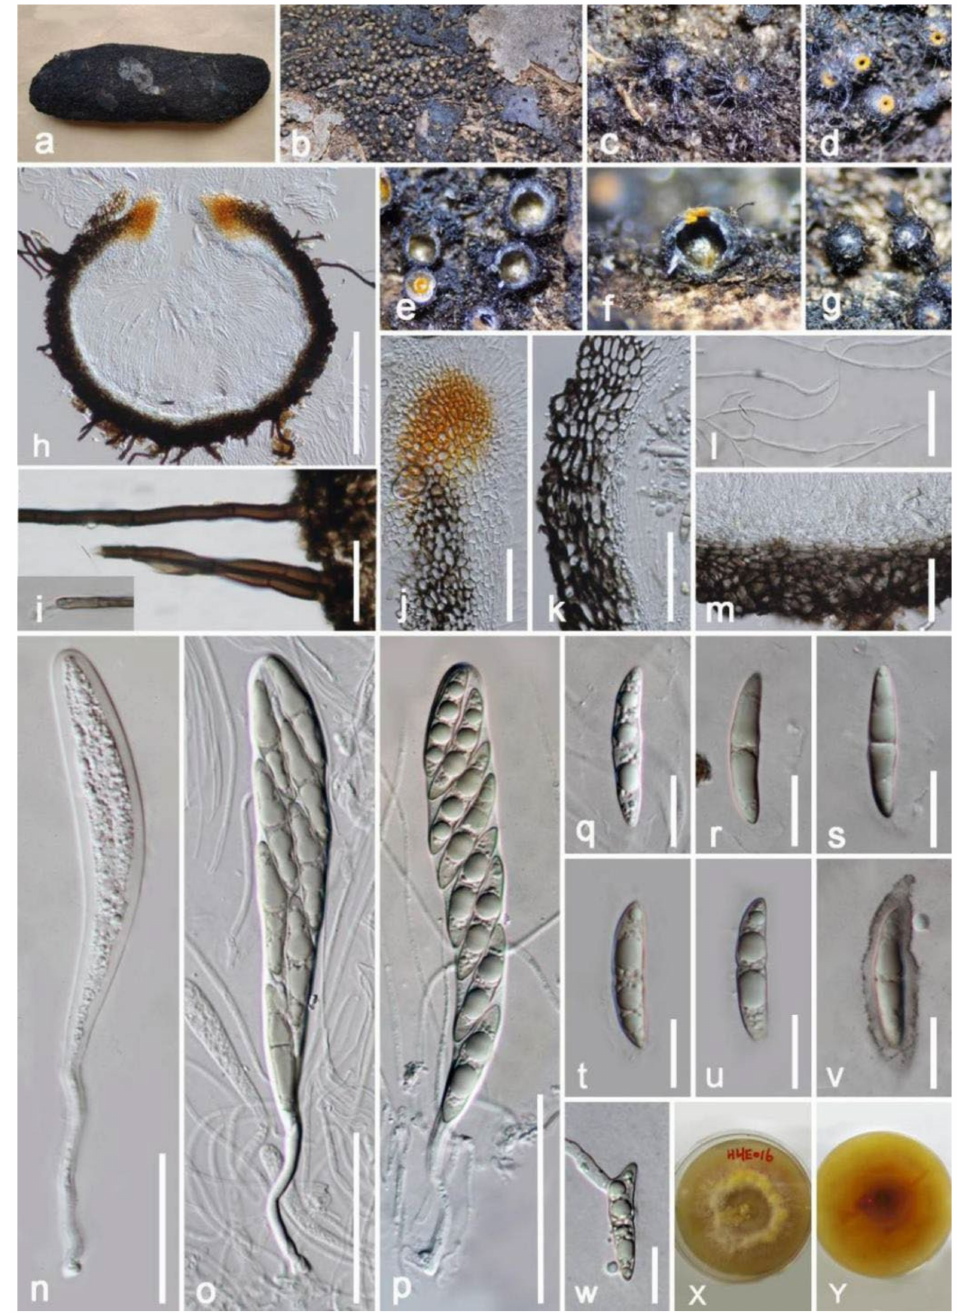
Figure 4. Byssosphaeria siamensis (HKAS 122197). ( a ) Ascomata on decayed endocarp of Mangifera indica ; ( b – d ) close-up of ascomata; ( e ) horizontal section of ascomata; ( f ) vertical section of ascomata; ( g ) bottom of ascoma; ( h ) section of ascomata; ( i ) setae; ( j ) peridium near ostiole; ( k ) peridium at side; ( l ) pseudoparaphyses; ( m ) peridium at base; ( n – p ) immature and mature asci; ( q – v ) as- cospores; ( w ) germinated ascospore; ( x , y ) colony on PDA with pigment. Scale bars: ( h ) = 200 µ m; ( j , k , m , o , p ) = 50 µ m; ( i , l , n ) = 30 µ m; ( q – w ) = 15 µ m. Mangifericomes E.F. Yang and Tibpromma, gen.